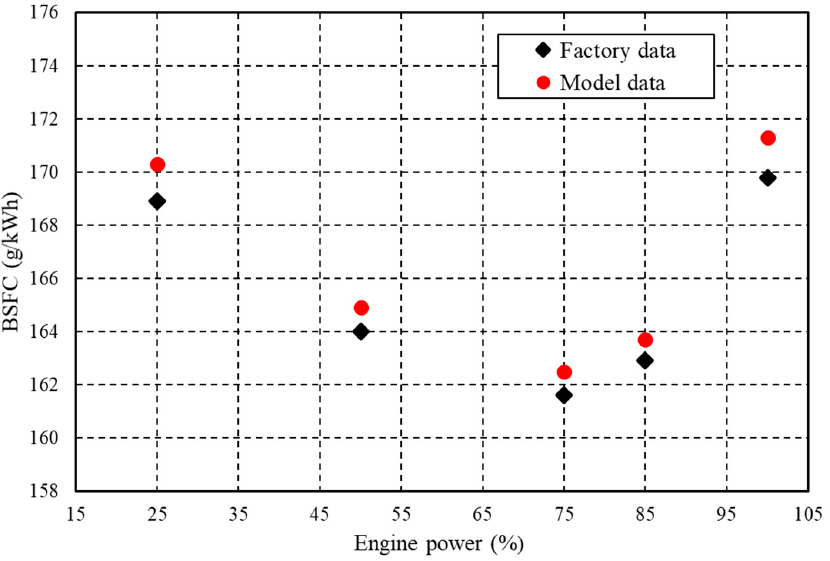
Figure 8. Speci fi c fuel consumption of the WinGD X62-B diesel engine in the range from 25% to Figure 8. Specific fuel consumption of the WinGD X62-B diesel engine in the range from 25% to 100% MCR. 100%